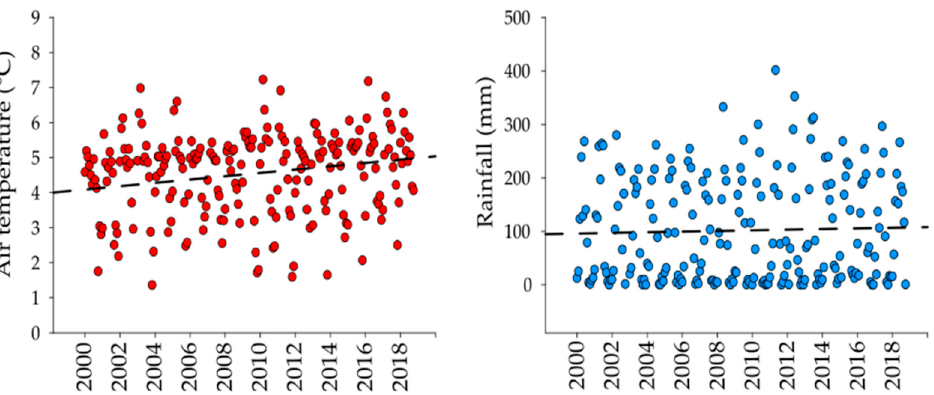
Figure 2. Air temperature (red dots) and rainfall (blue dots) trends from 2000 to 2018. Dots represent monthly average values of air temperature and rainfall. (Automatic Meteorological Station Nevado de Toluca SMN-15062).